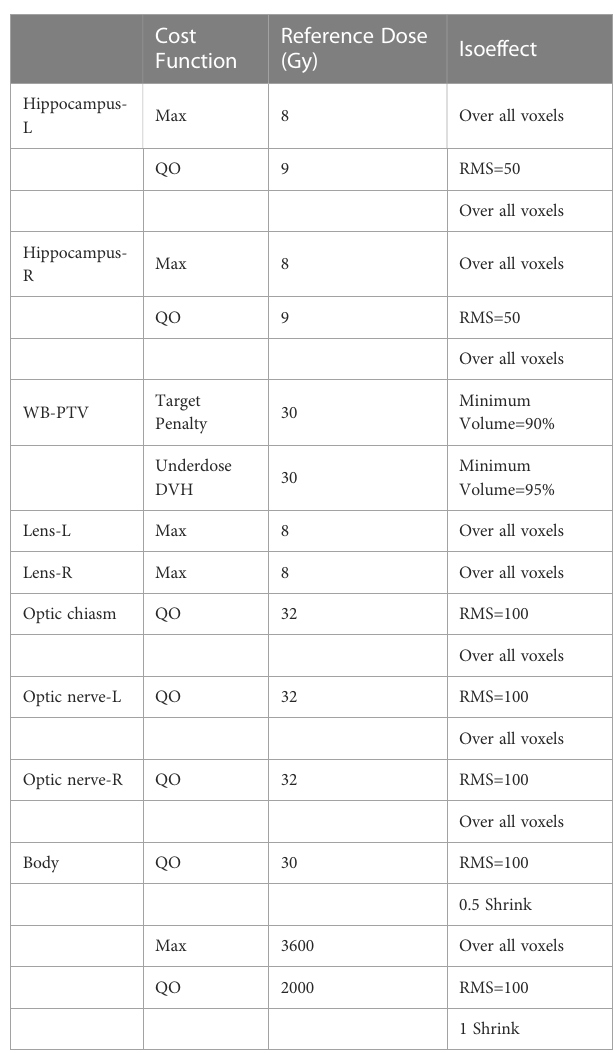
TABLE 3 Cost function template for planning a NC-VMAT of HA-WBRT plan in